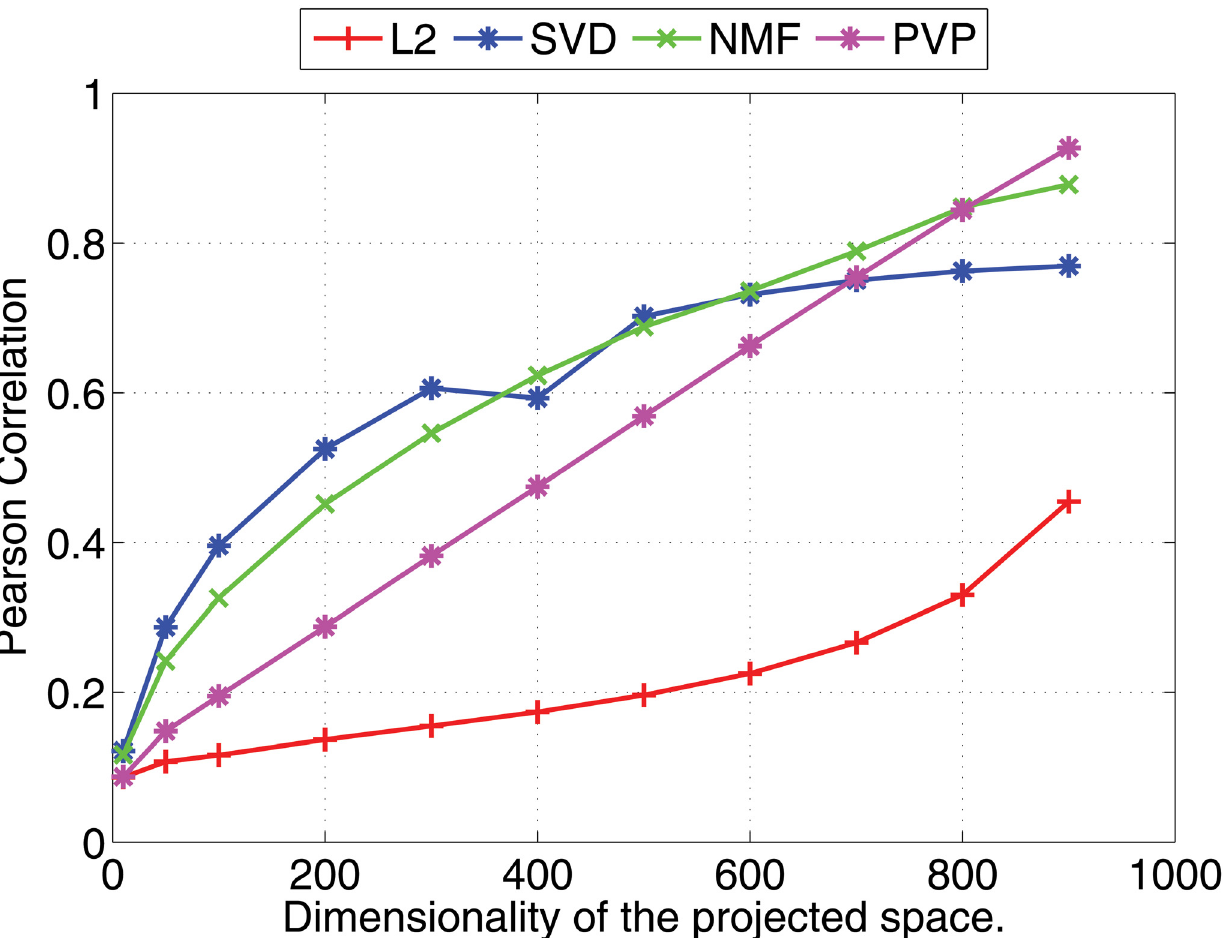
Fig 3. Nearest neighbor prediction with artificial data. Pearson ’ s r correlation coefficients for different dimensionality reduction methods are shown under varying dimensionalities (Feature vectors are 10000